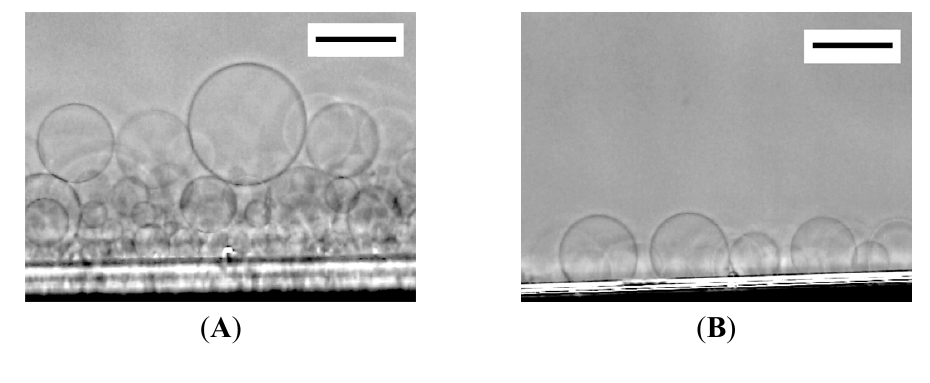
Figure 1. Electroformation of giant vesicles (GVs) from phospholipid deposit on a Pt wire electrode in ultrapure water at 120 min after the application of ac voltage (2.0 Vpp, 10 Hz). Images are GVs formed from relatively thick lipid deposit ( A ), and semi-spherical “mushrooms” from thin deposit ( B ). The electrode appears as the black shadow at the bottom of the frame. Bar = 50 μ m.